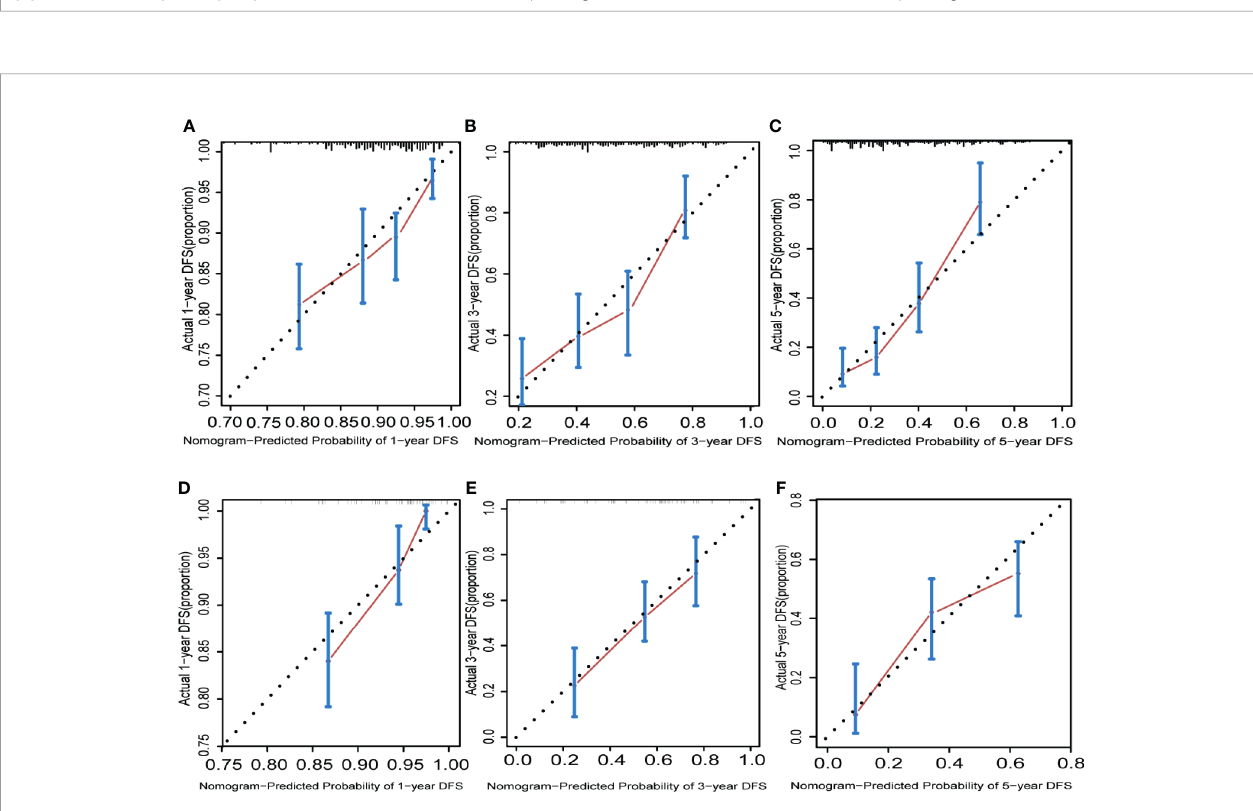
FIGURE 5 | Hepatocellular carcinoma calibration curve. The calibration curve for predicting OS at 1 years (A) for training cohort; (D) for validation cohort), 3 years (B) for training cohort; (E) for validation cohort) and 5 years (C) for training cohort; (F) for validation cohort) in HCC patients. Nomogram-predicted probability of overall survival is plotted on the x axis and actual overall survival is plotted on the y